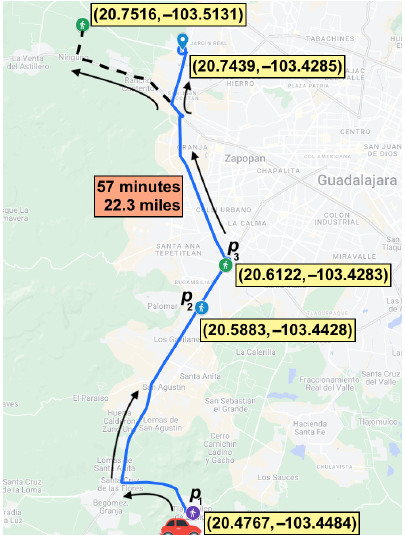
Figure 7. The route R d (shown in blue) in which driver d offers a ridesharing service in the Metropoli- tan Zone of Guadalajara,